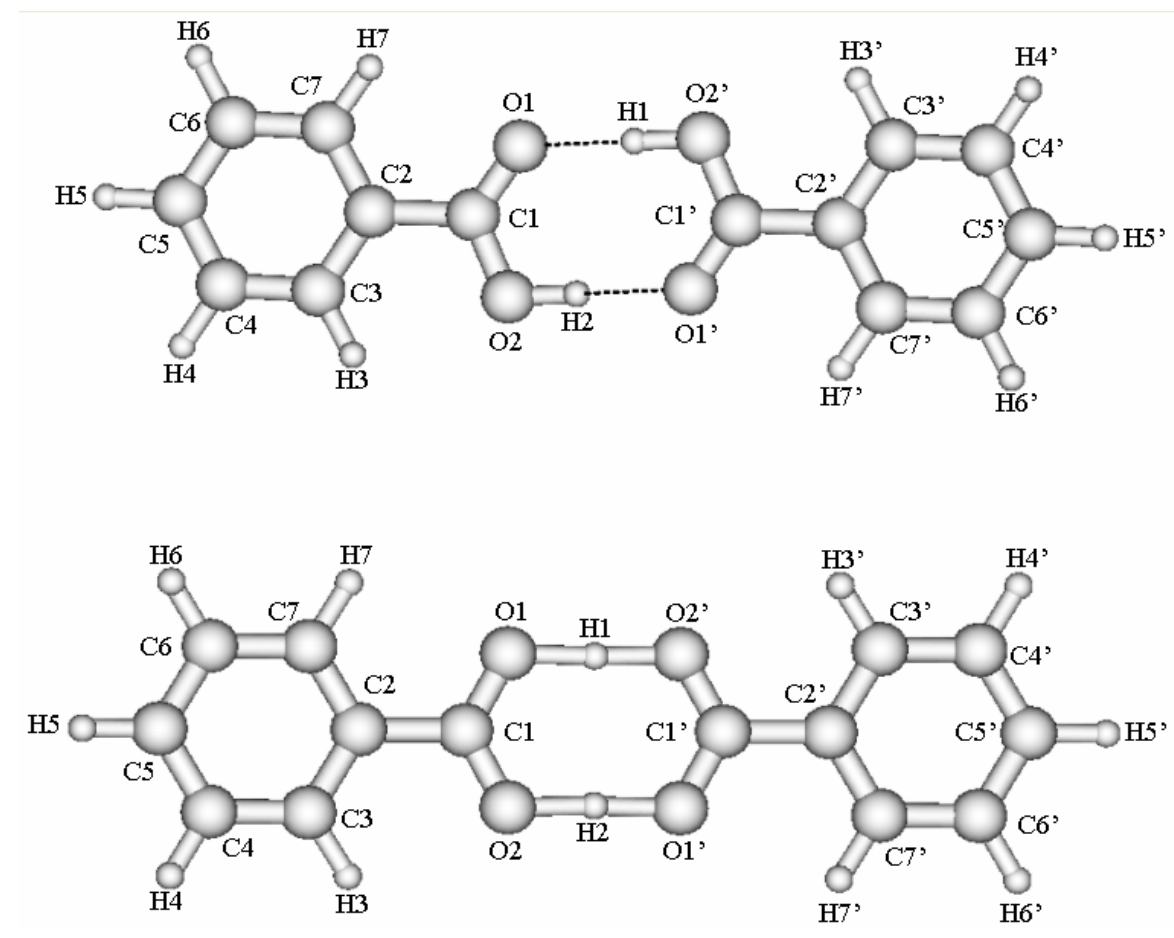
Figure 1. Benzoic acid in the stable and saddle point